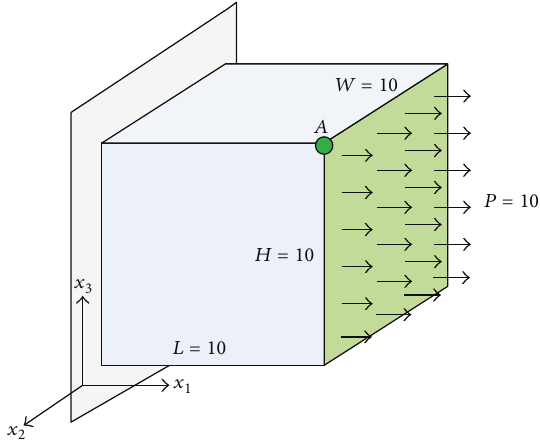
Figure 8: Cubic block under uniform tension and body force: geometry, boundary condition, and loading.